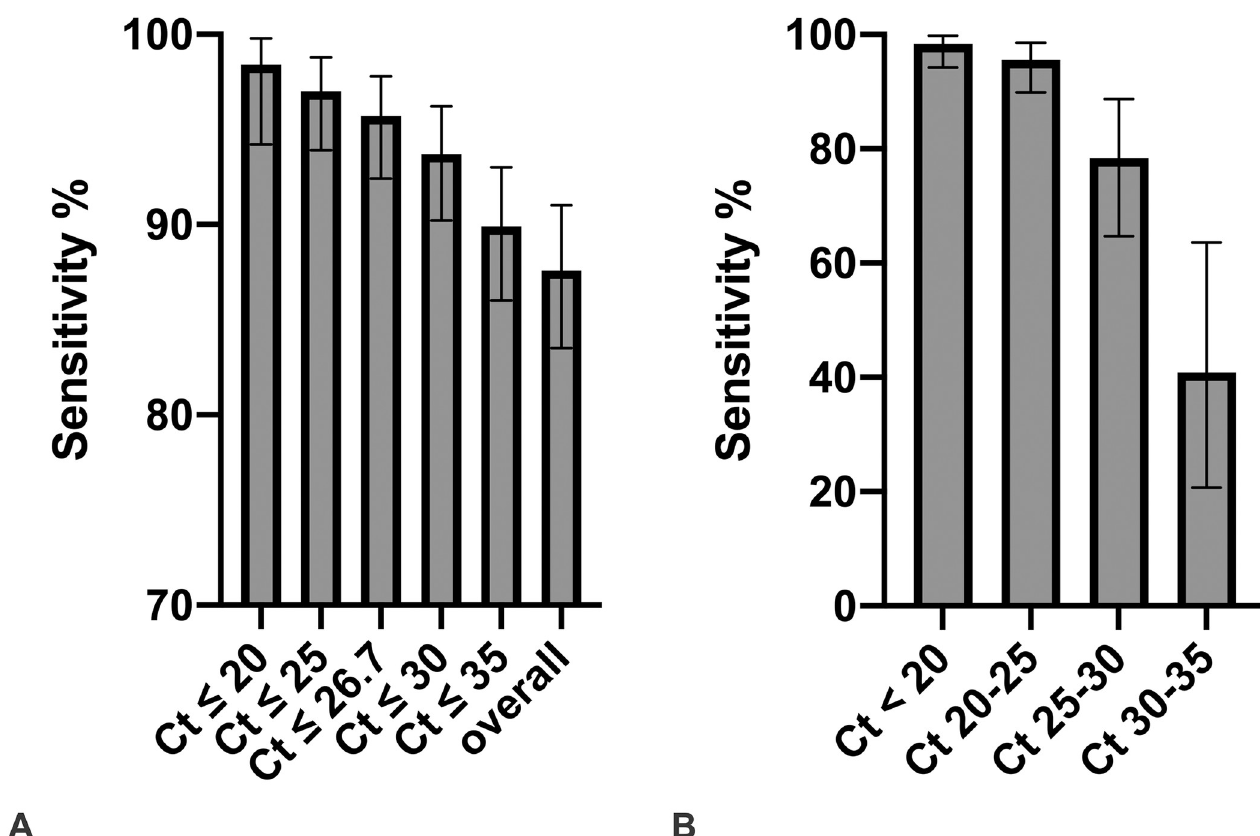
Fig 3. A. Combined SN of the two Ag-RDTs according to Ct-values of the RT-PCR. B. Combined SN of the two Ag-RDTs according to subgroups of Ct-values of the RT-PCR. Ct values correspond to the following SARS-CoV-2 RNA copy numbers/mL: Ct 20: 1.0E8; Ct 25: 3.2E6; Ct 26.7: 1E6; Ct 30: 1.0E5, Ct 35: 3.2E3.